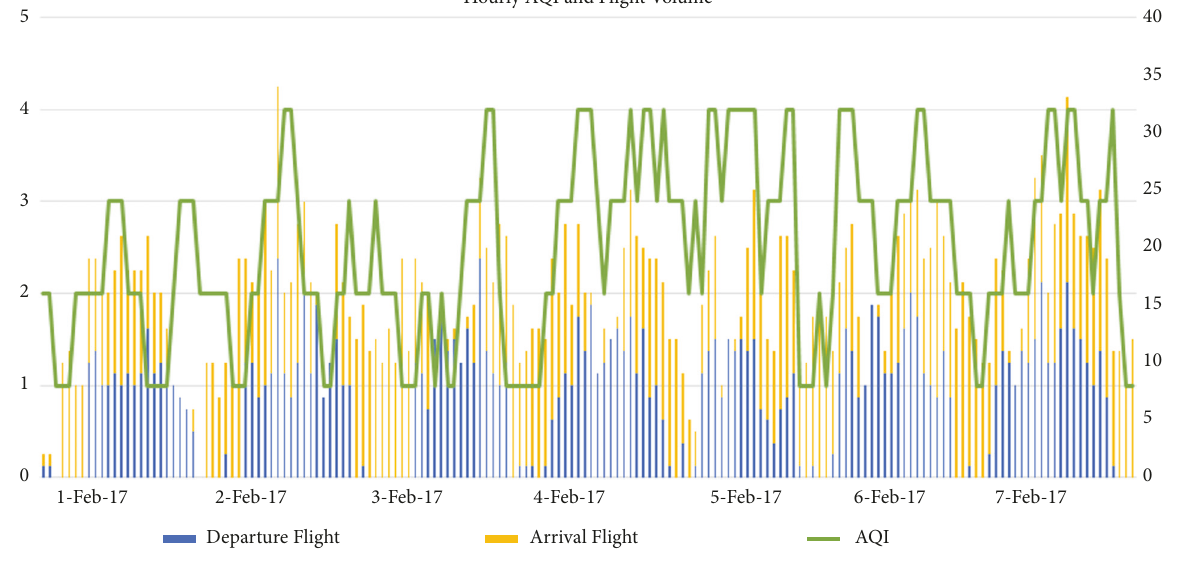
Figure 5: Sample hourly AQI and flight volume for ZSNJ in 2017.